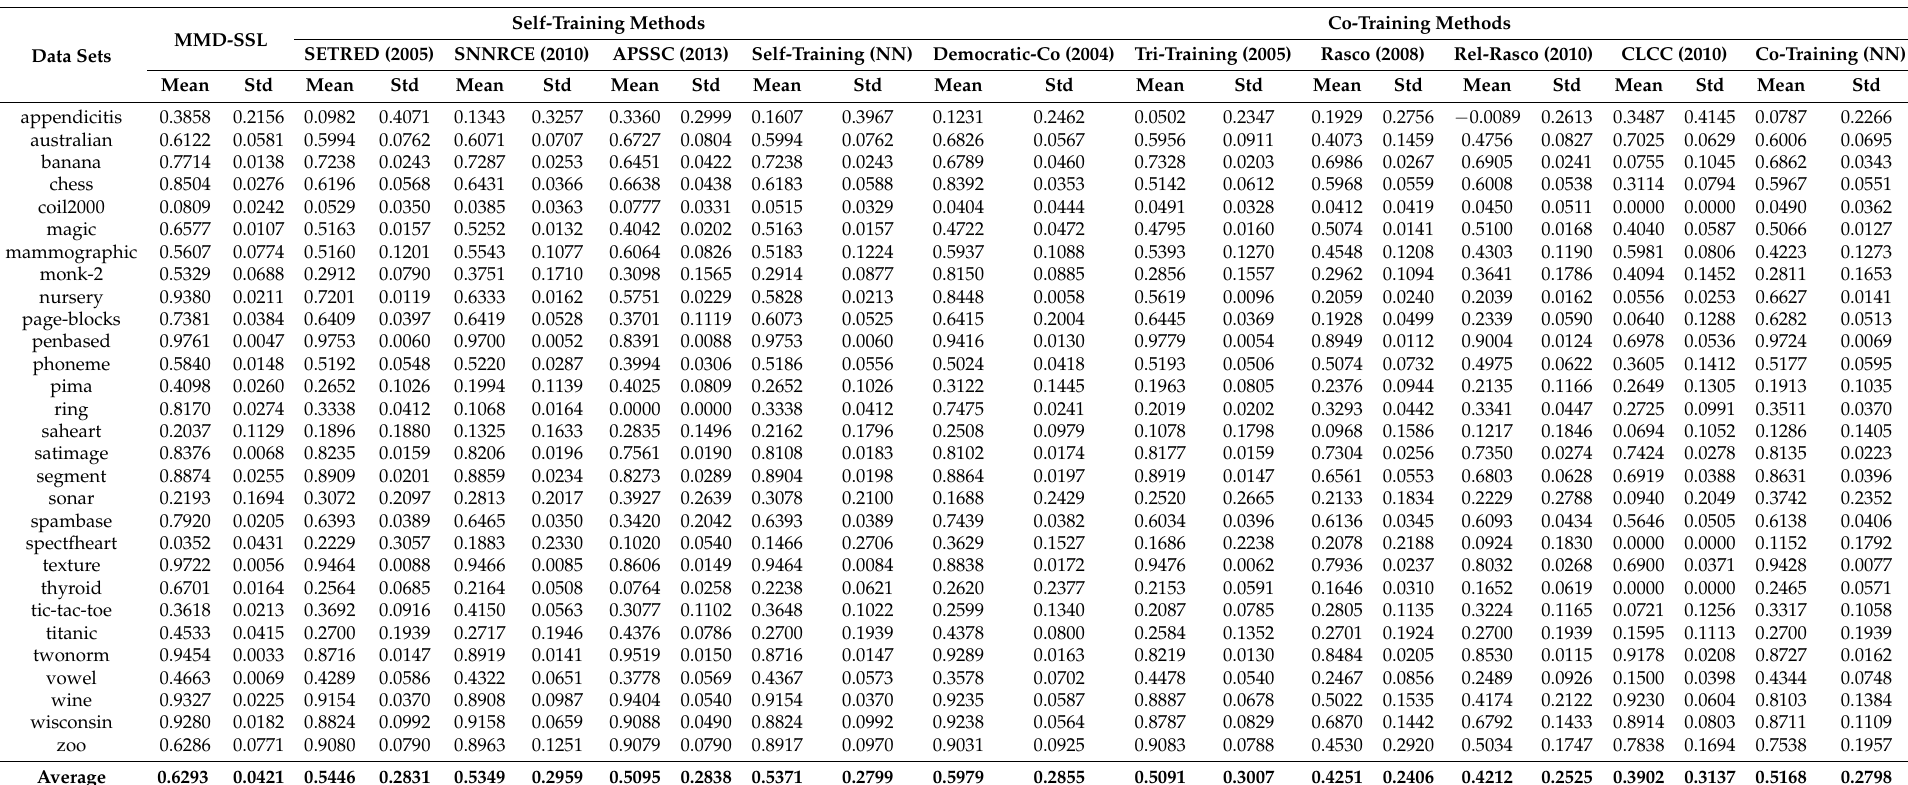
Table 5. Kappa comparison of MMD-SSL algorithm and 10 other SSL algorithms on 10% labeled data.